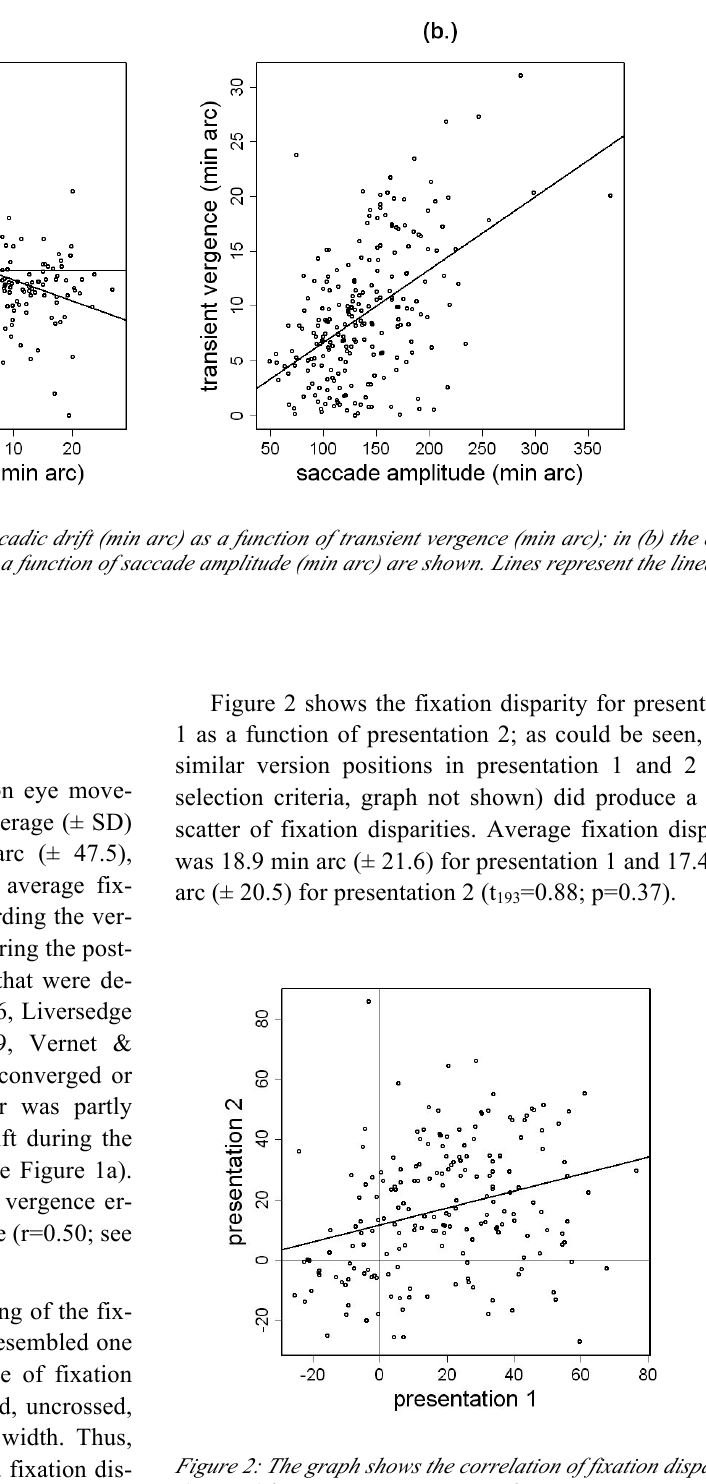
Figure 2: The graph shows the correlation of fixation disparity (min arc) between presentation 1 and 2.